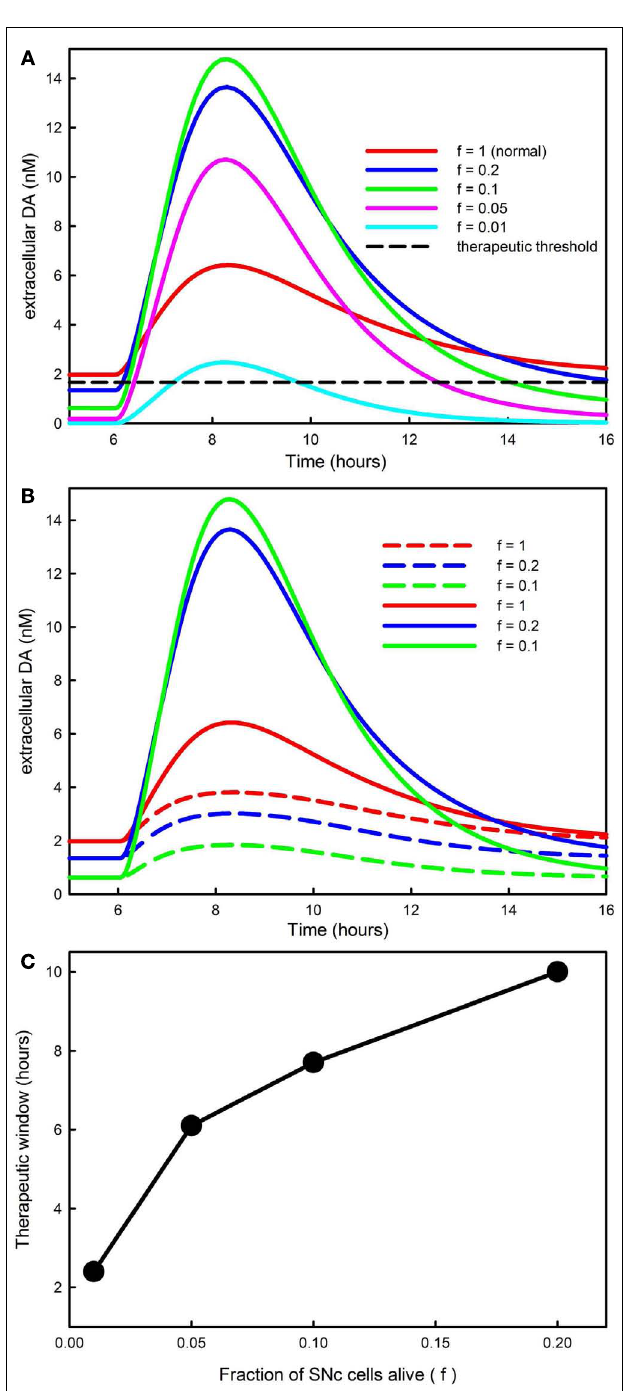
FIGURE 7 |The progression of PD affects DA in the striatum and the therapeutic time window. (A) Shows the time course of extracellular DA in the striatum for different values of f , the fraction of SNc cells left alive. As f declines the curves get higher because there are fewer DATs to take up the DA released by 5HT neurons. However, when f is very small the peaks decline because removal mechanisms such as catabolism and diffusion become more important.The dashed black horizontal line in (A) represents the level of extracellular DA needed in the striatum for